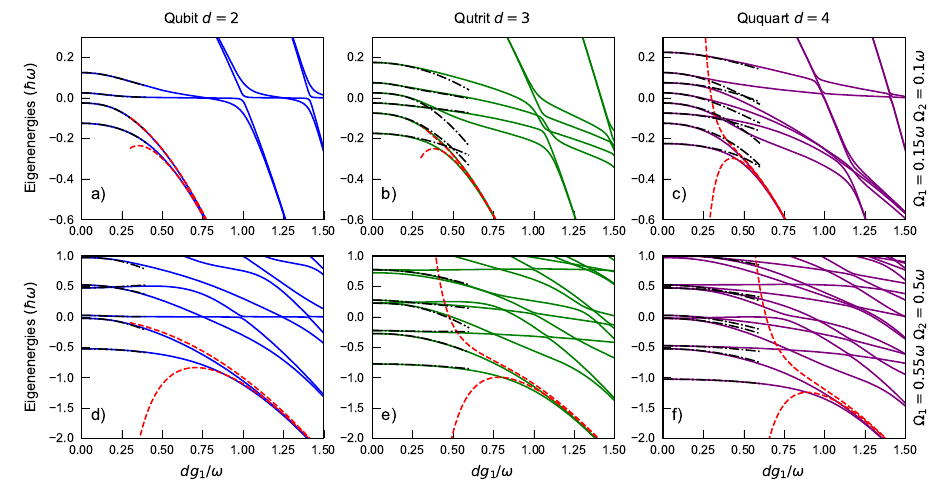
Figure 2: Hamiltonian energy spectrum with qudit dimensions d = 2,3,4. (a)-(f) Low energy spectrum vs coupling strength g obtained through numerical diagonal- ization of the full Hamiltonian Eq. (1) (solid). The numerical results are compared to the low coupling approximations (black dotted-dashed) of Eq. (9) (see also Ap- pendix A for the qutrit and the ququart cases), and d -order perturbation approx- imation Eq. (11) (see also Appendix C for the qutrit and the ququart cases) in = g = g and (top panels) the ultrastrong coupling regime (red dashed), for g 1 2 Ω = 0.15 ω , Ω = 0.1 ω , (bottom panels) Ω = 0.55 ω , Ω = 0.5 ω 1 2 1 2